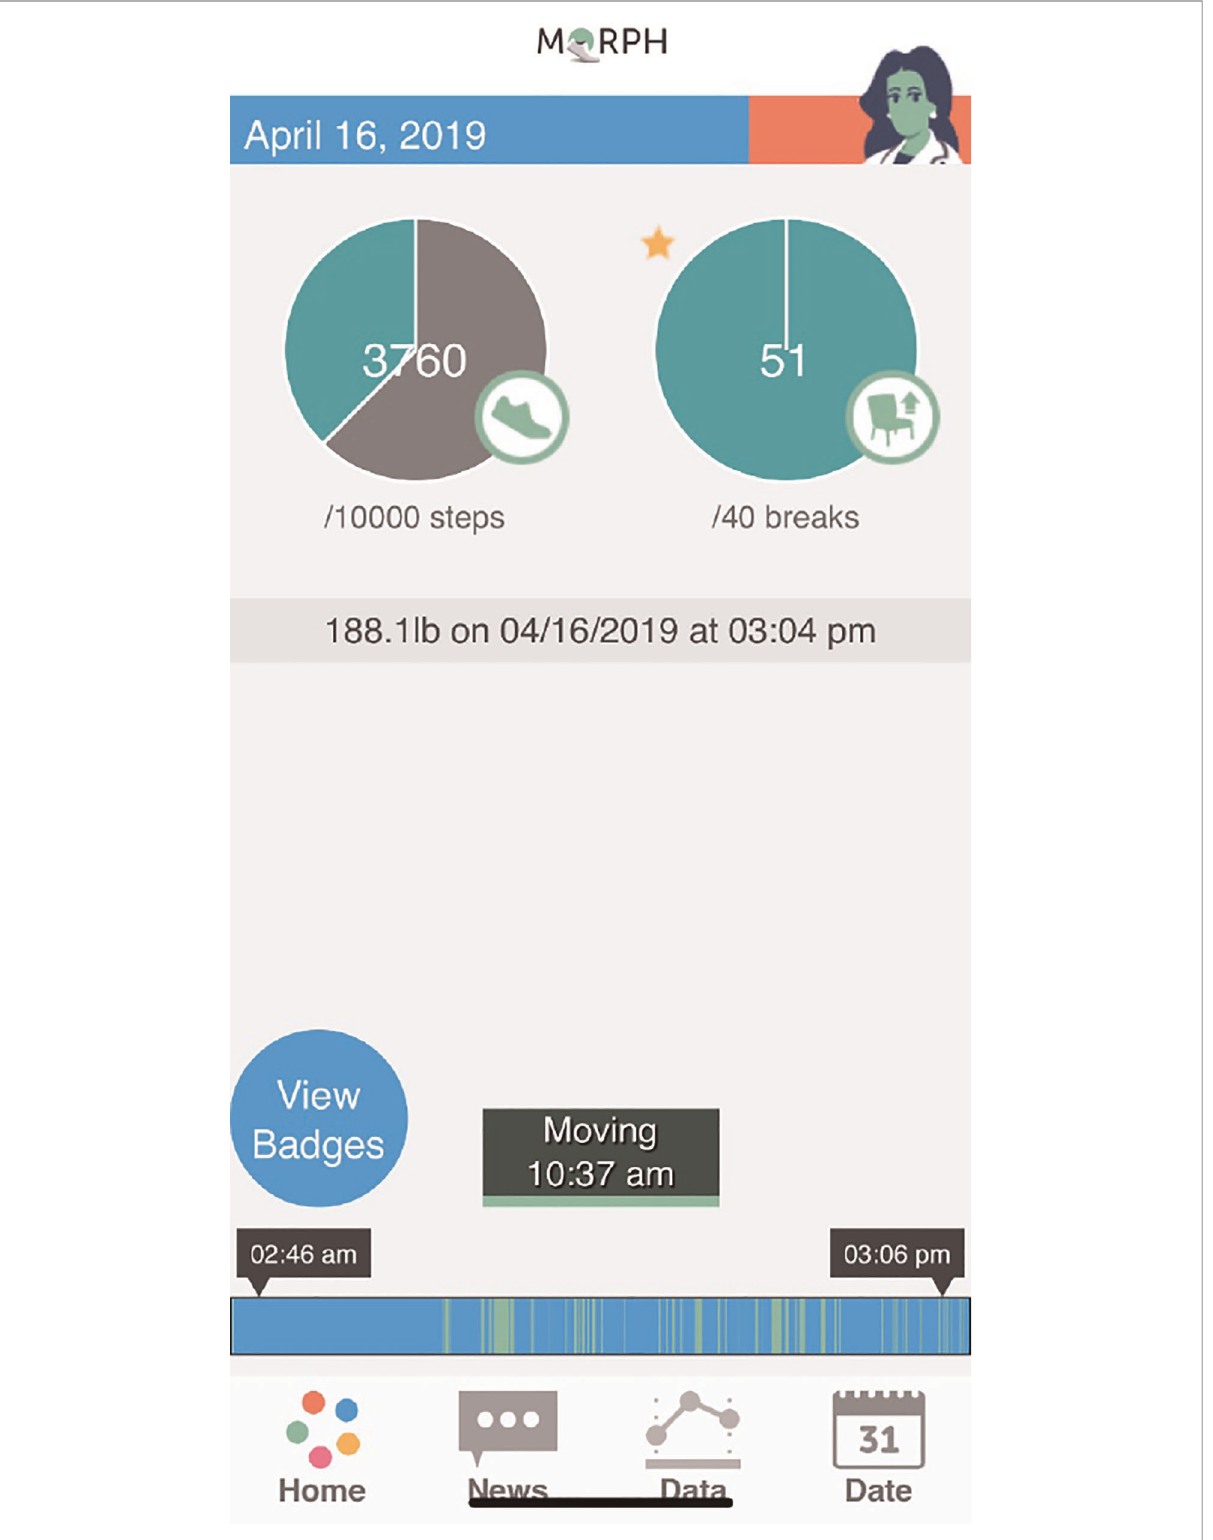
FIGURE 2 Example Companion App